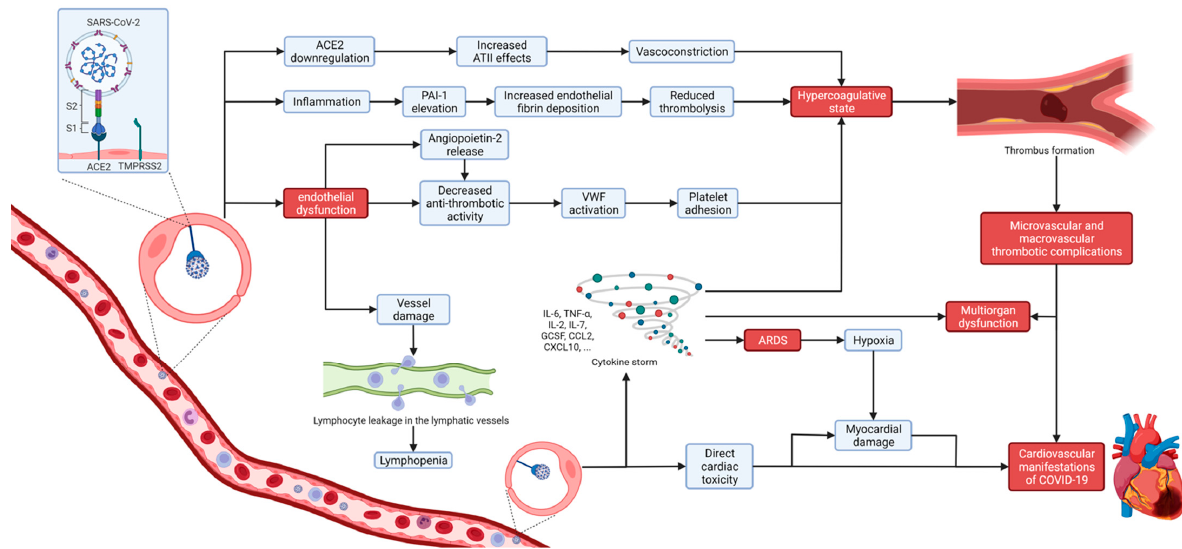
Figure 1. Schematic representation of COVID-19 induced endothelitis. SARS-CoV-2 binding to ACE2 on endothelial cells induces inflammatory-mediated changes and endothelial dysfunction that causes the characteristic hypercoagulative state. In turn, causing micro- and macrovascular thrombotic events often seen in severe COVID-19 patients. Created in Biorender.com (Accessed on 06/11/2021). TMPRSS2—transmembrane protease serine 2; ACE2—angiotensin-converting enzyme 2; ATII—angiotensin II; PAI1—plasminogen activator inhibitor 1; VWF—von Willebrand factor; IL-6—interleukin 6; IL-2—interleukin 2; IL-7—interleukin 7; TNF- α —tumor necrosis factor- α ; GCSF—granulocyte colony-stimulating factor; CCL2—chemokine (C-C motif) ligand 2; CXCL10—C-X-C motif chemokine 10; ARDS—acute respiratory distress syndrome.